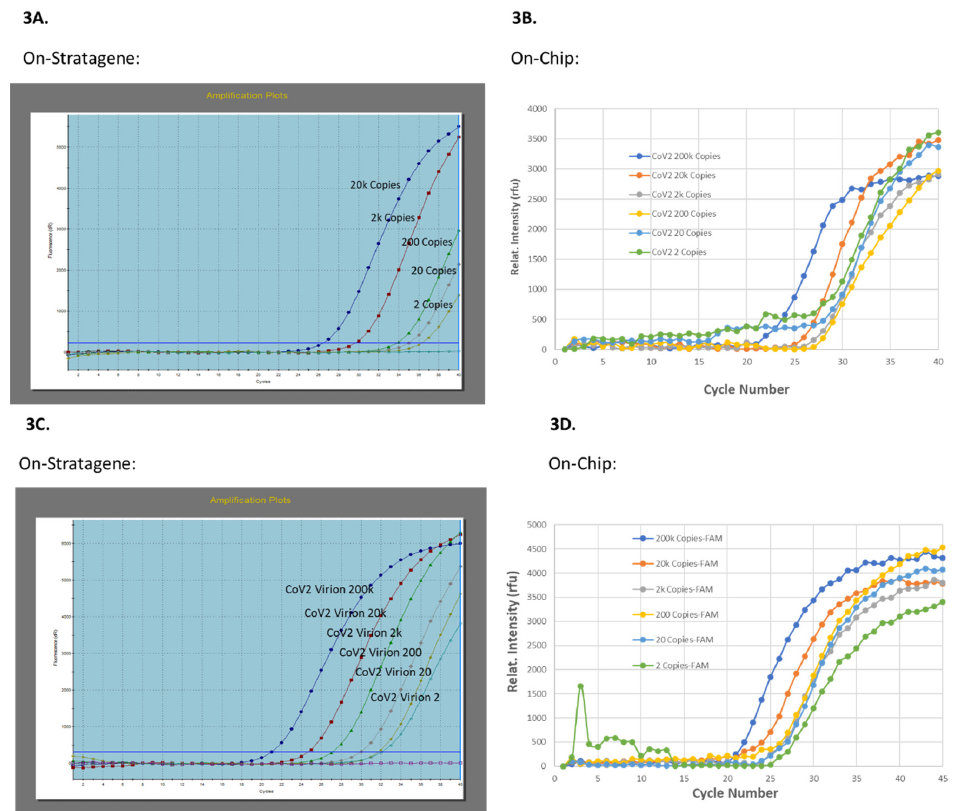
Figure 3. Evaluation of on-MiDAS Peltier thermal cycling unit. Detection of SARS-CoV-2 spiked in saliva was compared between laboratory benchtop equipment ( 3A , 3C ) and on-chip ( 3B , 3D ). 1-Step RT-qPCR was performed with the N1-FAM primer. The viral copy number dose-response curves were generated with either the SARS-CoV-2 plasmid-RNA ( 3A , 3B ) or with γ -irradiated SARS-CoV-2 virions ( 3C , 3D ).